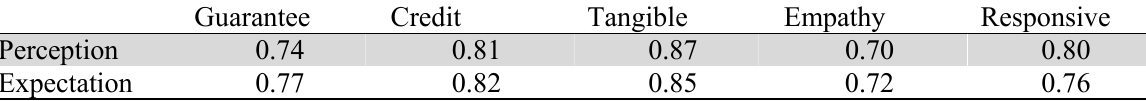
The summary of SERVQUAL questionnaire (Overall